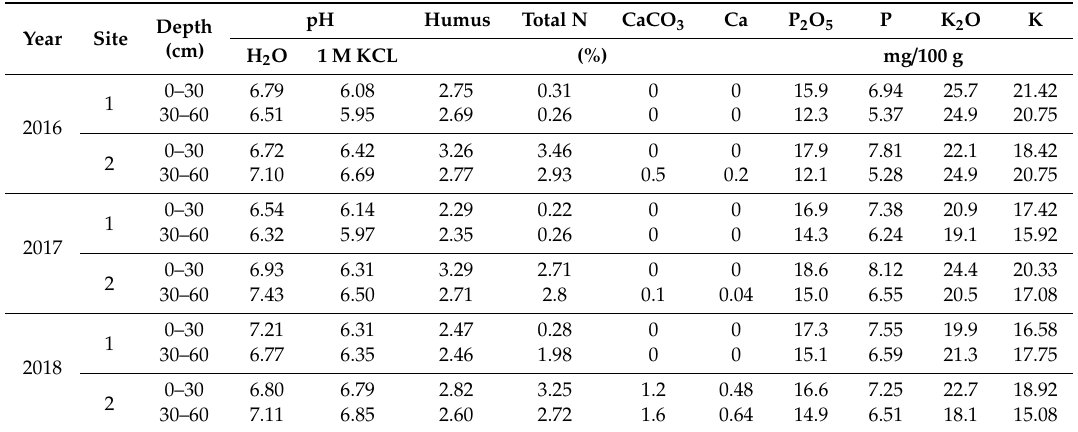
Table 1. Basic chemical properties of soil at sites 1 and 2.